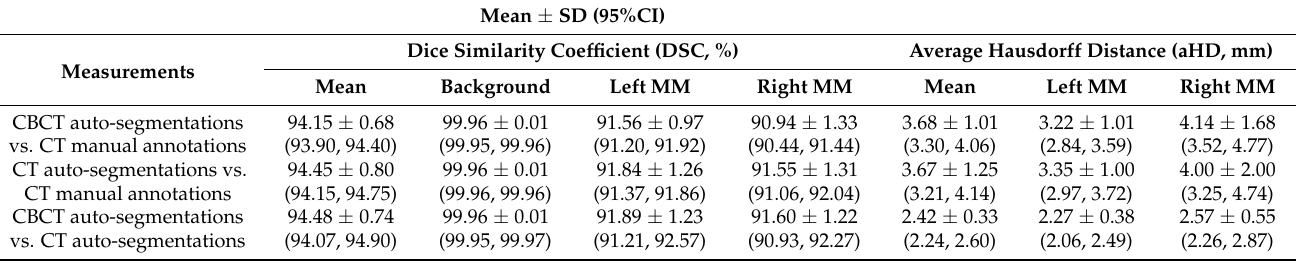
Table 2. The evaluation of model performance by Dice similarity coefficient (DSC, %) and average Hausdorff distance (aHD, mm) among 15 cases.